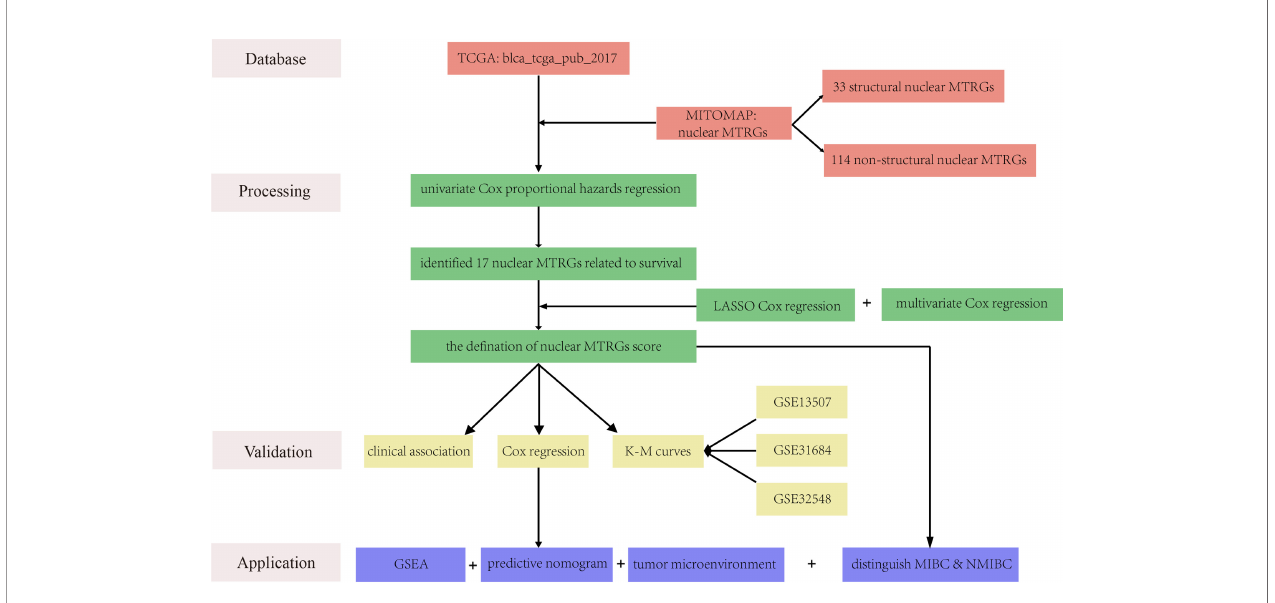
FIGURE 1 | A work fl owchart of the establishment of a nuclear MTRGs-based signature in